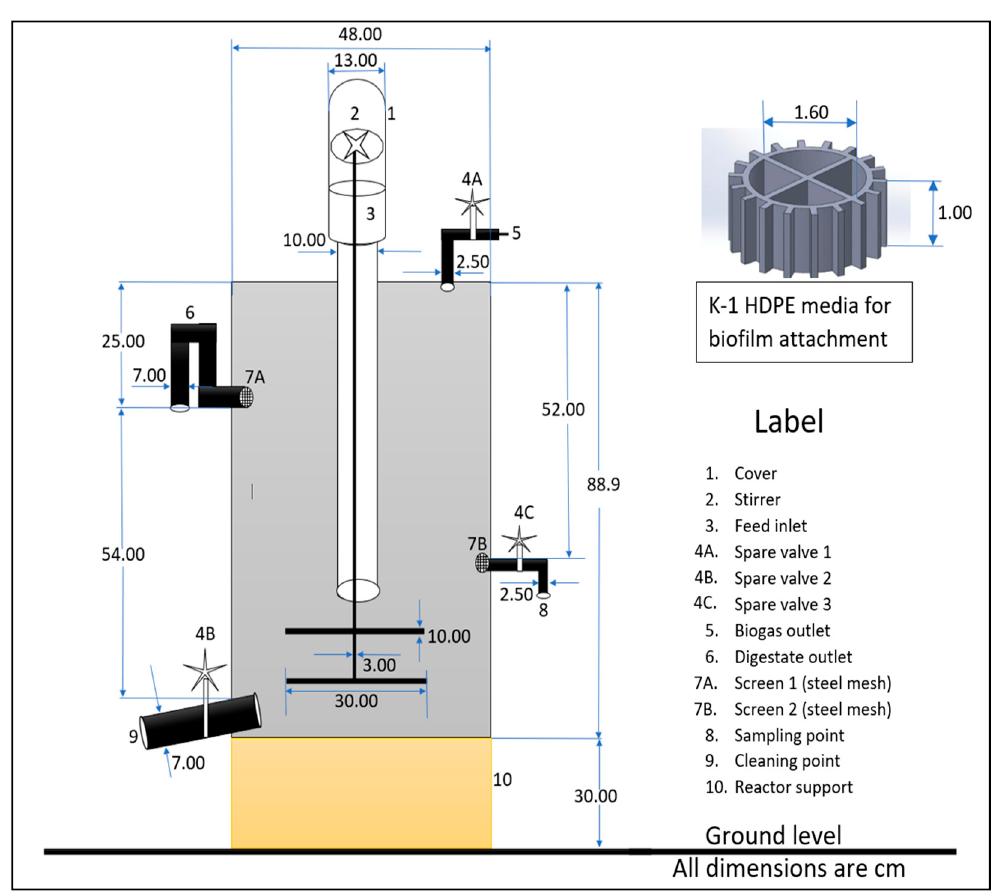
Figure 1. Schematic diagram of the single-stage anaerobic biofilm digester system.